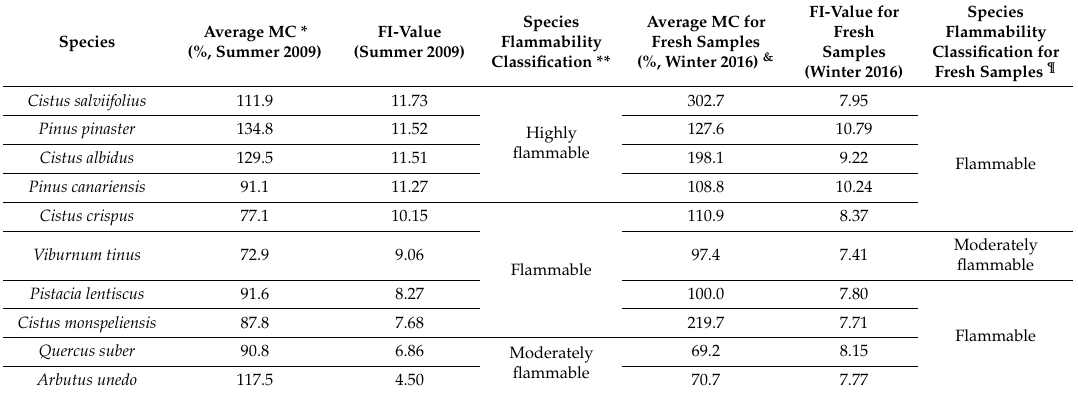
Table 7. Practical example of the use of MC-values in the FI calculation for both the MC-values obtained during the present work (winter 2016) and the average MC-values delivered by Hachmi et al. [43] which were determined during the critical summer period of July–September